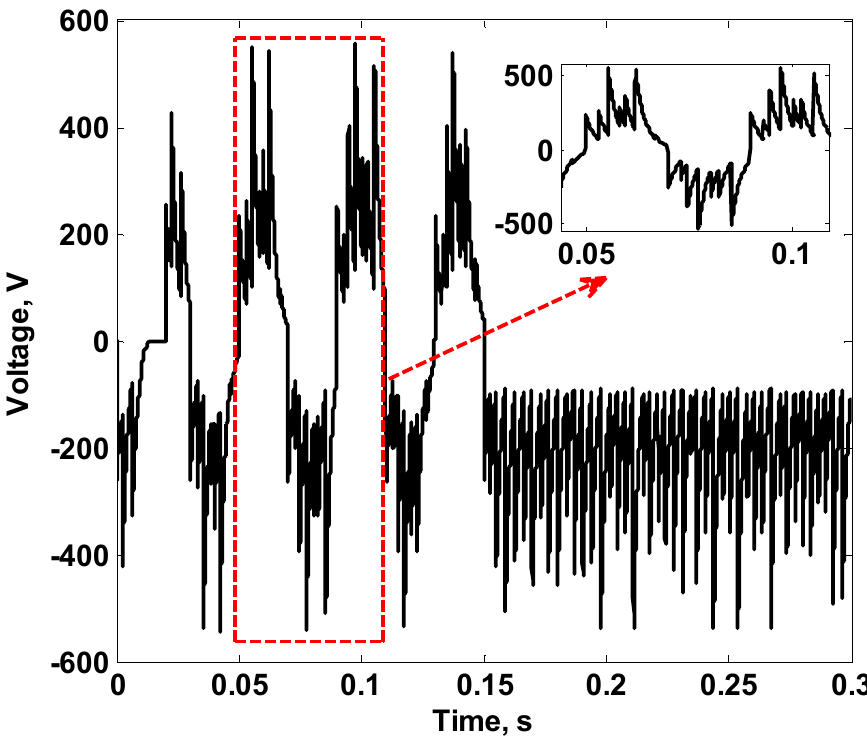
Figure 34. Conditions of 110 V, 25 Hz with a Transfer to a DC Signal of − 200 V at 0.15 s.